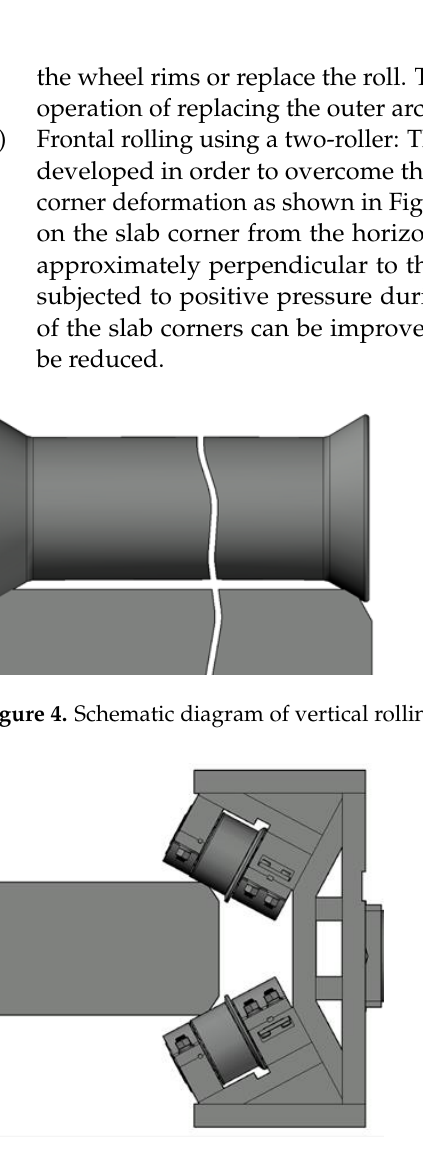
Figure 5. Schematic diagram of frontal rolling using a two-roller at the chamfered slab corner.